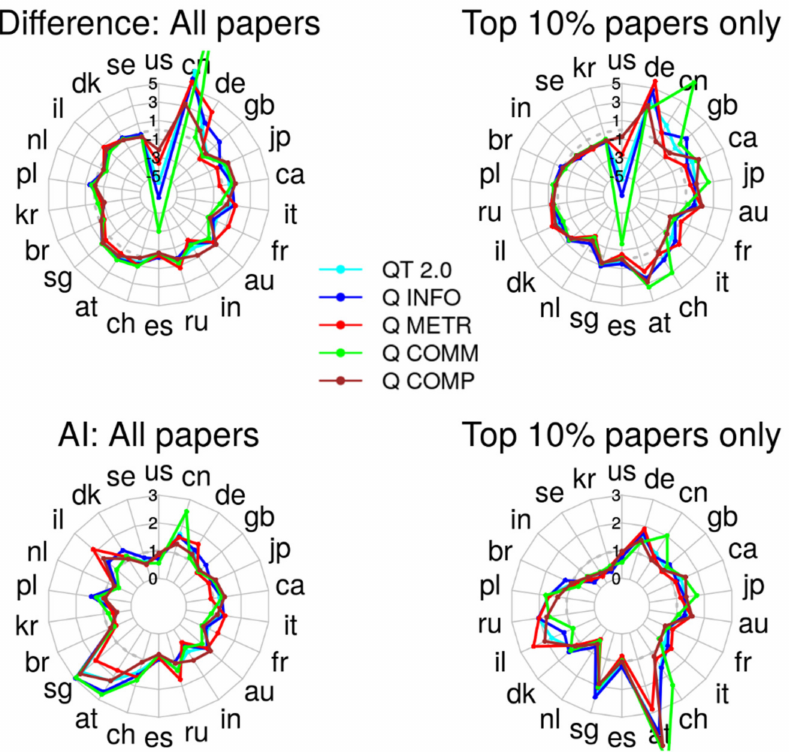
Figure 4. Radar charts of the differences (upper graphs) and quotients (activity indices, lower graphs) of the national shares of papers in QT 2.0 and its four fields from 2000 to 2018. On the left side, all papers are included; on the right side, only the top 10% most cited papers in the time period 2000–2016 are included. The 22 countries, which are among the top 25 in all fields and the whole QT 2.0, are denoted by their country codes, and ordered clockwise in descending order of the number of publications. The gray dashed lines at 0 and 1 indicate the expected output of the